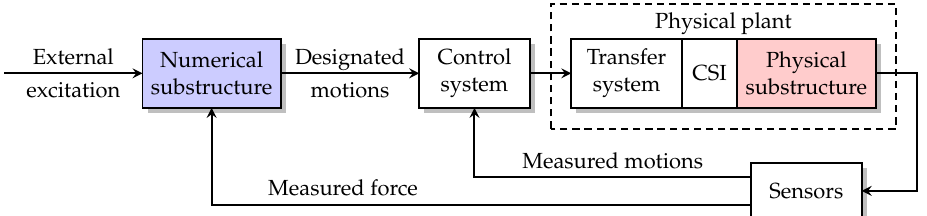
Figure 5. RTHS block